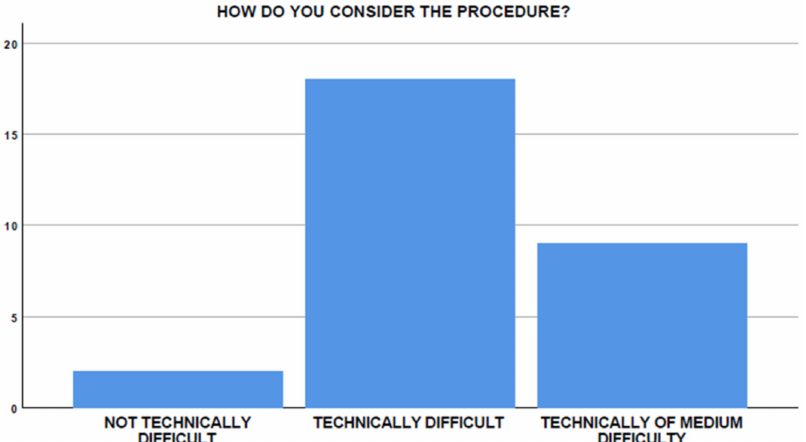
Figure 7. Perceived difficulty of